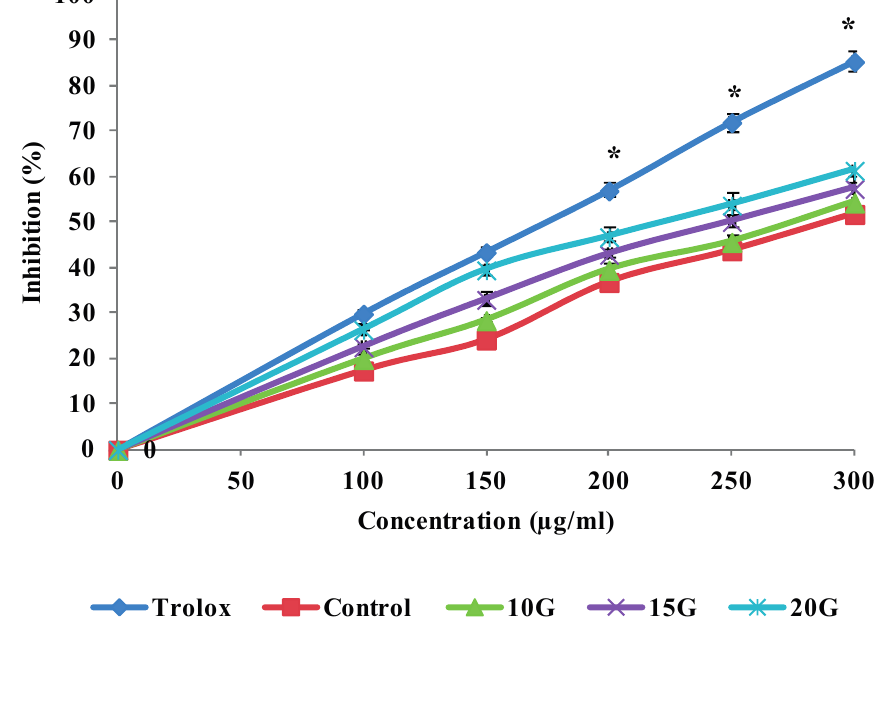
Figure 4. Effect of gamma irradiation on the ABTS radical scavenging activities of methanolic extracts and positive control at different concentrations. Values are means ± SE. Each value represents the mean of three replications. * Significance different from Control group at the same concentration. Significance was determined at p <